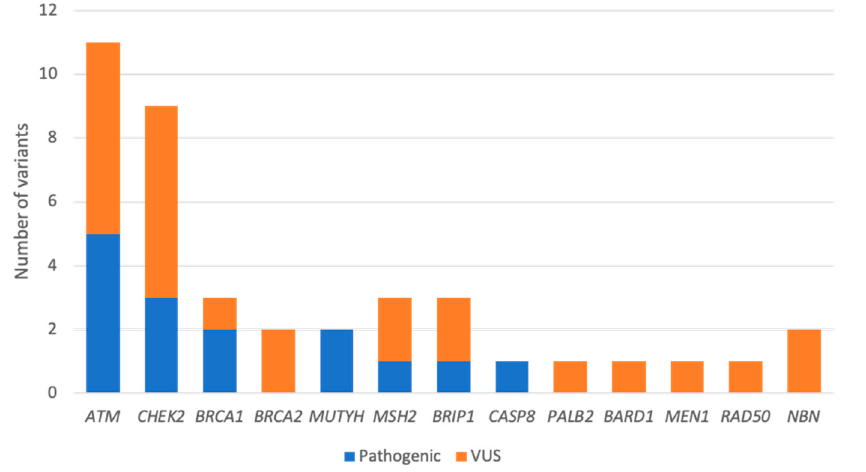
Figure 2. Distribution of germline variants detected by an NGS panel of 41 genes. Variants are classified as pathogenic (Class 4 or 5) or VUS (Class 3).